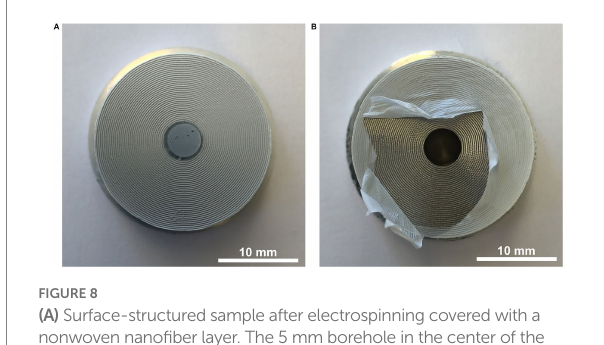
FIGURE 8 (A) Surface-structured sample after electrospinning covered with a nonwoven nanofiber layer. The 5 mm borehole in the center of the sample is fully covered with the nonwoven layer, which enables peel- off force measurement. (B) Surface-structured sample after peel-off force measurement. The nonwoven layer was removed without leaving any residues (the weight applied during peel-off force measurement for this sample was increased until the nonwoven layer